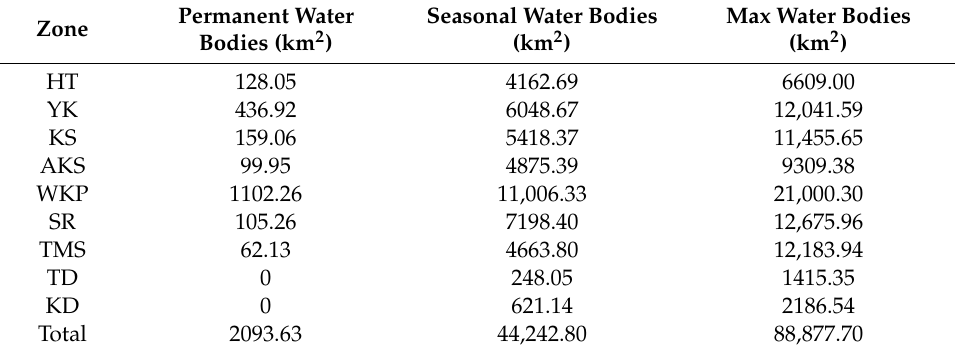
Figure 6. The spatial distribution of open-surface water bodies from 1986 to 2019 in the TRB: ( a ) the source of the mainstream of the Tarim River, ( b ) Bosten Lake, ( c ) Daxihaizi Reservoir, ( d ) Yarkant River, ( e ) Tetema Lake, and ( f ) Lop Nor Potash Plant. Table 2. The area of open-surface water bodies from 1986 to 2019 in the TRB. HT, Hotan River Basin; YK, the Yarkant River Basin; KS, Kashgar River Basin; AKS, Aksu River Basin; WKP, Weikan-Kaidu-Peacock River Basin; SR, Rivers in Southern Xinjiang; TMS, the Tarim Main Stream; TD, Taklamakan Desert; and KD, Kumtag